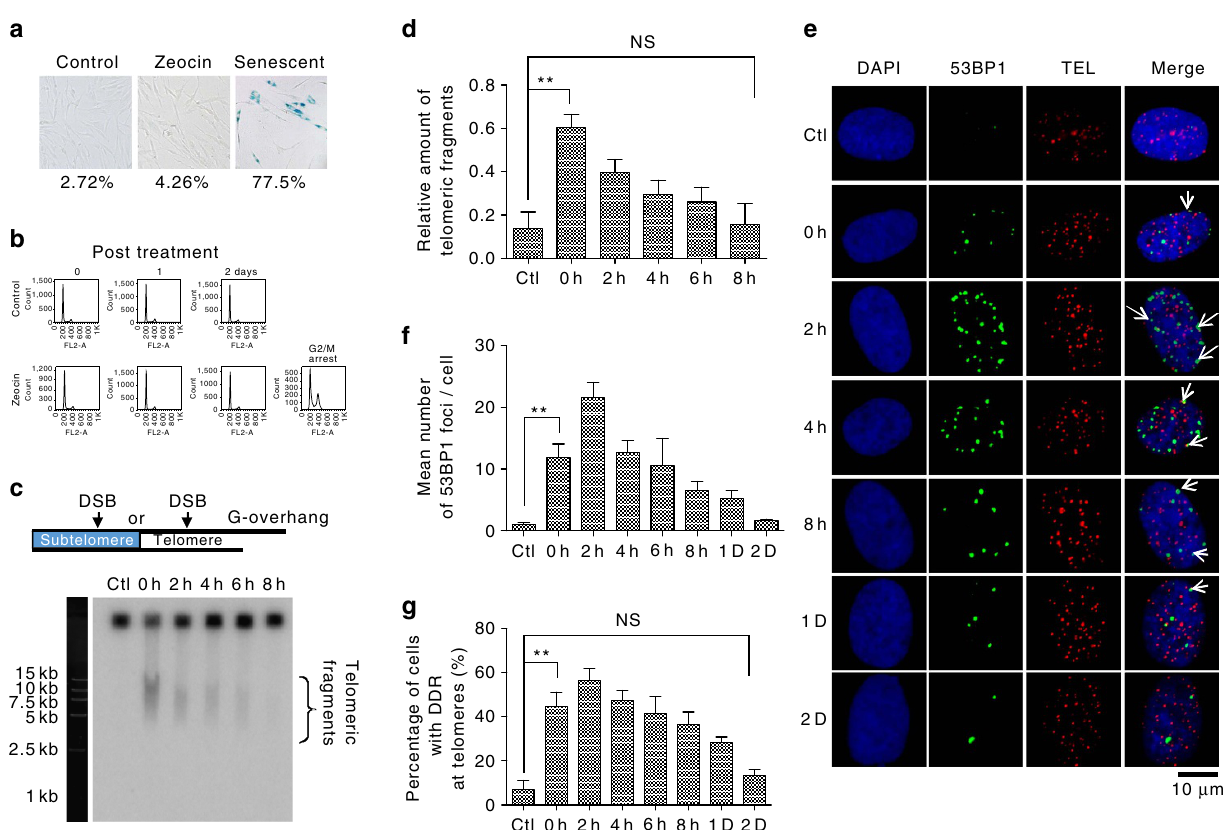
Figure 1 | Repair of telomeric DSBs in BJ fibroblast cells. ( a ) Cells were treated with zeocin (100 m gml (cid:2) 1 ) for 1h. Cells were stained to detect SA- b -gal activity before (Control) and 24h after treatment (Zeocin). Senescent BJ fibroblast cells were used as a positive staining control. ( b ) Zeocin treated (100 m gml (cid:2) 1 for 1h) and untreated cells (Control) were subjected to cell cycle FACS analysis. Stress-induced senescent cells were used as a positive control for G2/M arrest. ( c ) Cells were exposed to zeocin (100 m gml (cid:2) 1 ) for 1h and then given fresh medium for 0, 2, 4, 6 and 8h. Cells were collected at the indicated time points and analysed by constant-field gel electrophoresis (CFGE). Telomeric fragments were detected by hybridization of their G-rich overhangs with C-rich probe under native conditions. Corresponding MW was indicated on the left. ( d ) Quantification of c . The relative amount of G-rich overhang on telomeric fragments was determined as the signal intensity of the smear normalized to the intensity in the entire sample. Untreated cells served as a control (Ctl). ( e ) Cells were exposed to zeocin (100 m gml (cid:2) 1 ) for 1h and then given fresh medium for 0, 2, 4, 6, 8, 24 and 48h. Untreated cells served as a control (Ctl). DDR and telomeres were visualized using antibody against 53BP1 (IF) or a probe to a telomeric sequence (FISH), respectively. Arrows indicate merged foci. Scale bar, 10 m m. ( f ) Quantification of e . The mean number of 53BP1 foci per cell was determined. ( g ) Quantification of e . The number of cells with 1 or more 53BP1 foci coincident with the signal from the telomere probe was counted, and the percentage of cells with 1 or more telomeric 53BP1 foci per cell was calculated. All values are average ± s.d. of three independent experiments ( n Z 100). ** P o 0.01. The Student’s t -test was used to determine the statistical